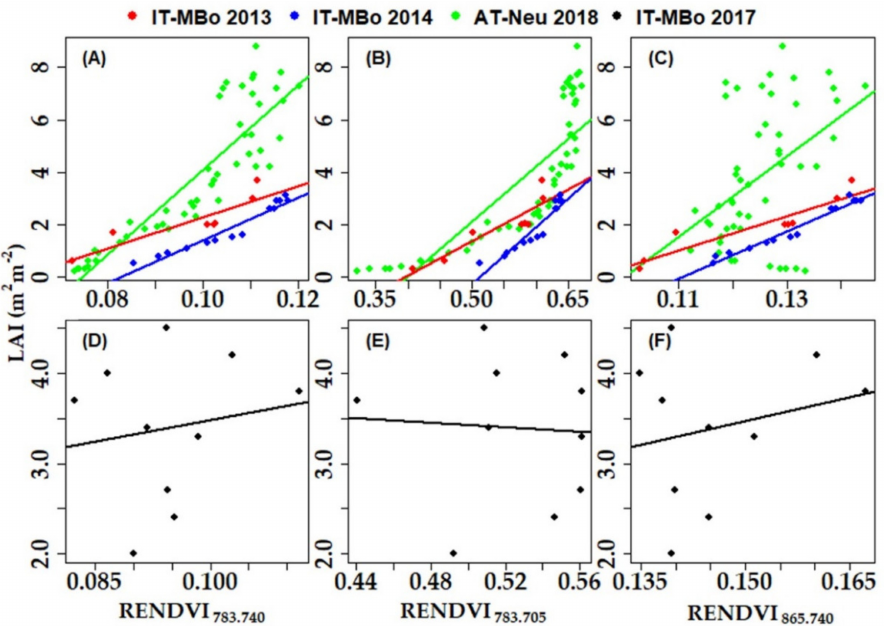
Figure 7. Relationship between RE indices and LAI: for temporal observations at IT-MBo (2013 and 2014) andAT-Neu 2018, respectively ( A – C ); and for spatial observations at IT-MBo 2017 ( D – F ). In all panels, solid lines represent a linear fit to the